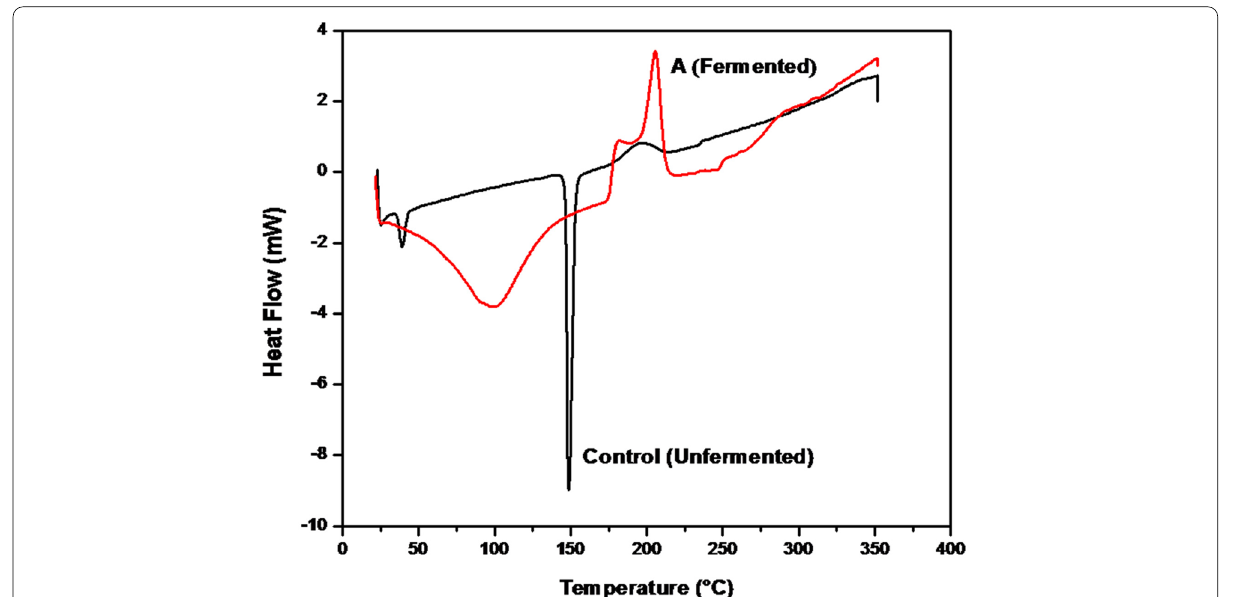
Fig. 7 DSC analysis pattern for cholesterol substrate powder control (unfermented), and A (fermented) after the fermentation process under optimal